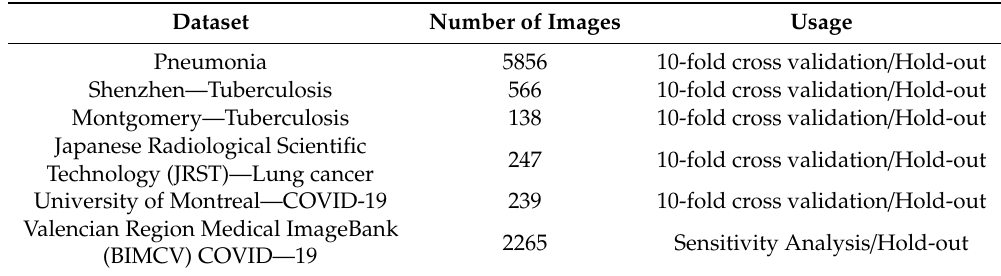
Table 1. Overall dataset distribution.